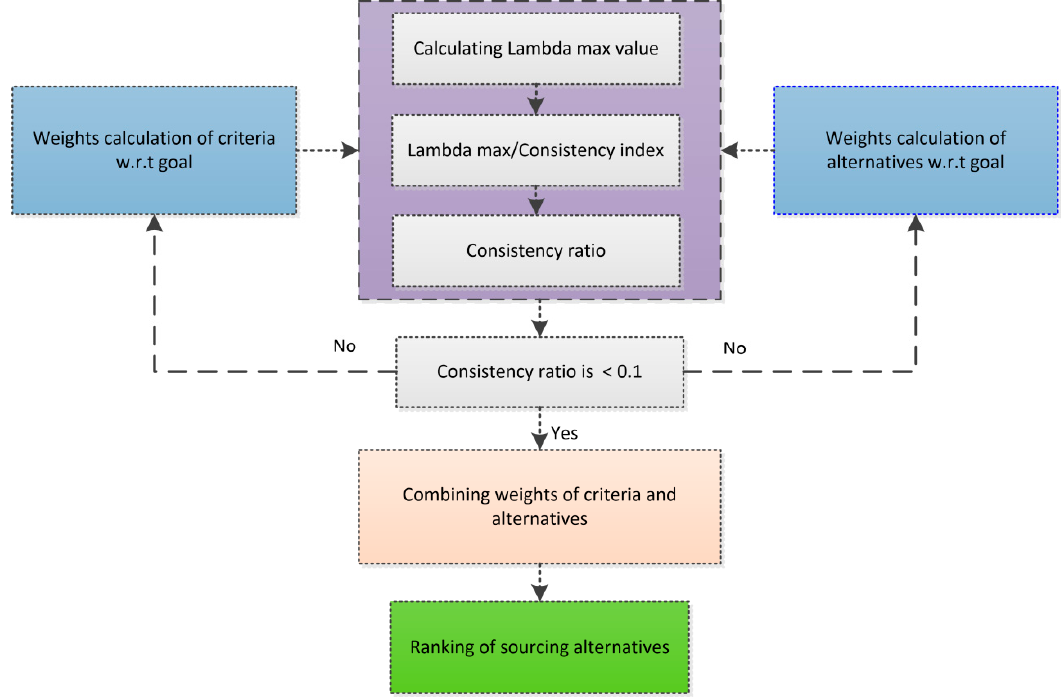
Figure 3. OffshoringDSS